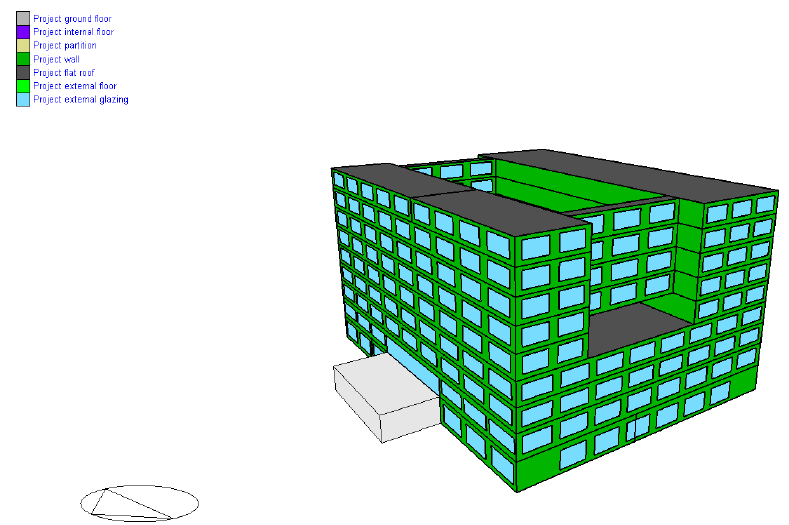
Figure 3. Outdoor temperature in Wuhan during the cooling period.